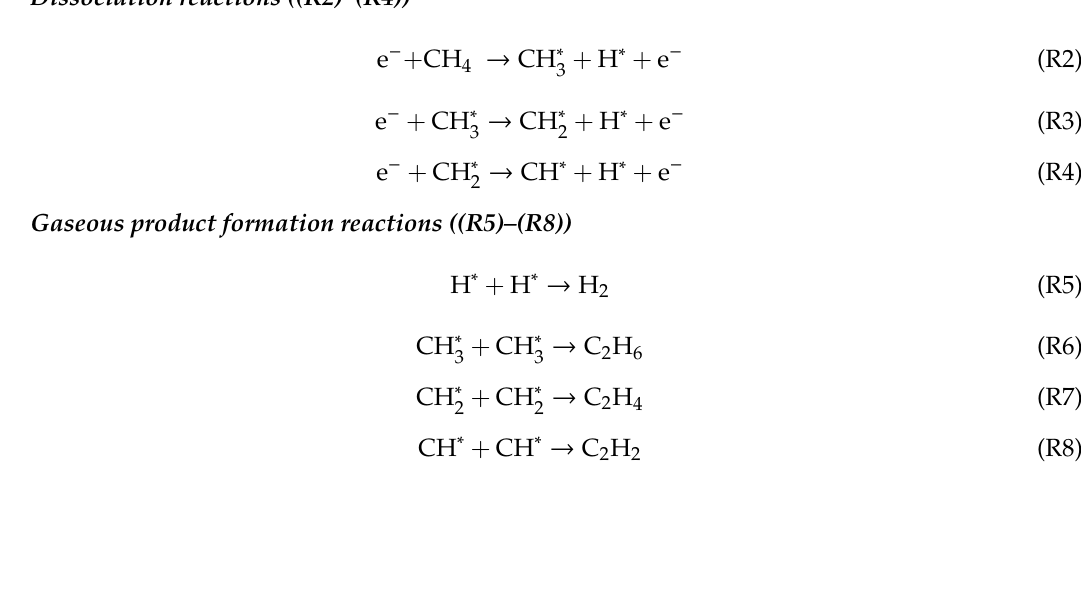
Figure 6. TGA analysis of fresh 10 wt% Ni/MgAl 2 O 4.